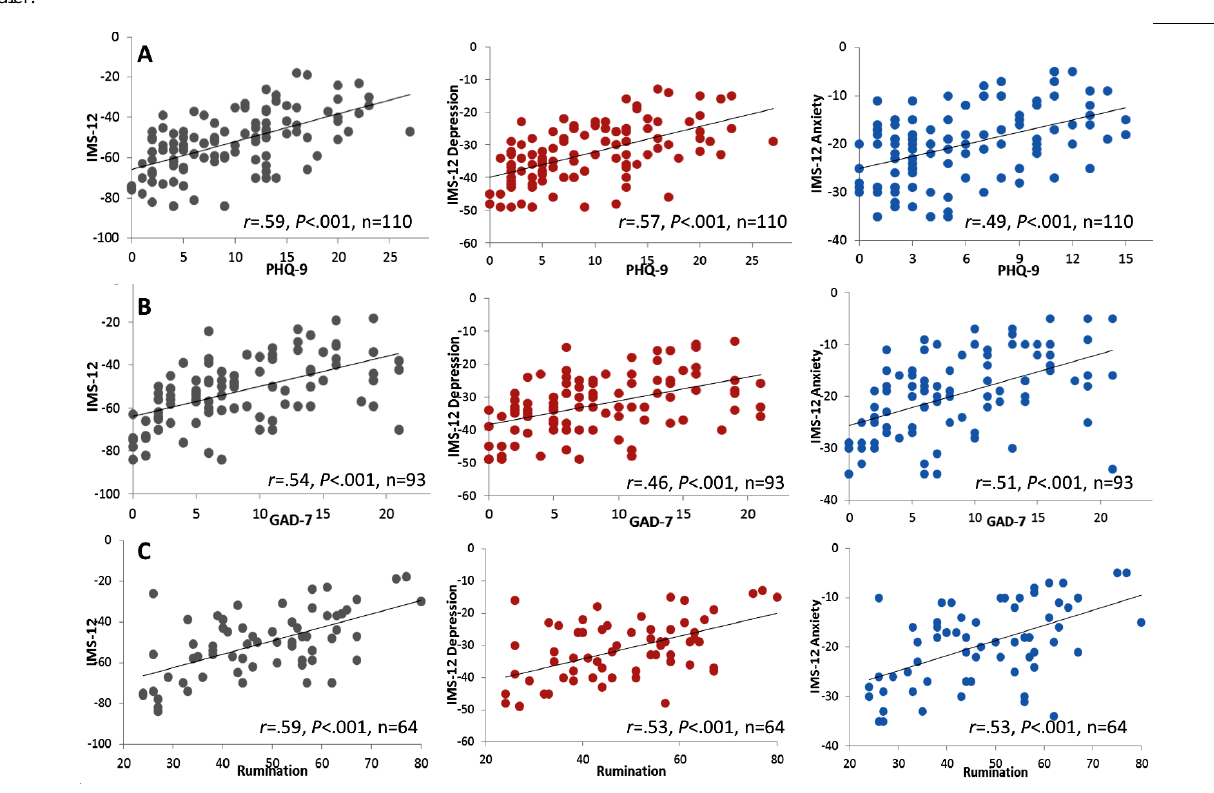
Figure 3. Correlations between IMS-12 and standardized scales. Correlations between IMS-12 total (left, gray), IMS-12 depression (middle, red), and IMS-12 anxiety (right, blue) with PHQ-9 (A; top row), GAD-7 (B; middle row), and rumination (C; bottom row) scales. Pearson r values and number of subjects are shown for each graph. PHQ-9: patient health questionnaire, 9-item. GAD-7: generalized anxiety disorder, 7-item. IMS: Immediate Mood